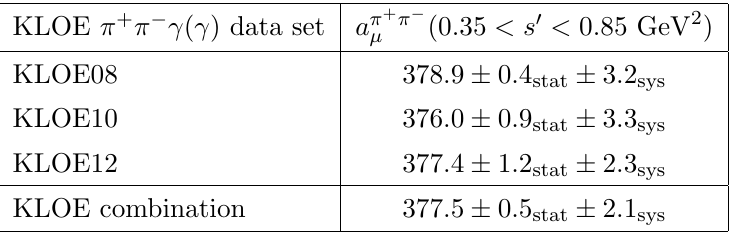
Table 2. Comparative results of the values obtained for a (cid:25) + (cid:25) (cid:0) individual KLOE measurements and the full combination. Results for a (cid:25) + (cid:25) (cid:0) of 10 (cid:0) 10 .